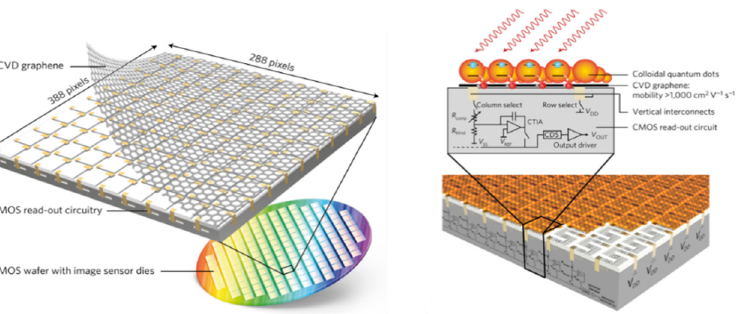
Figure 6. CMOS integration of CVD graphene with image-sensor readout circuit. Embedding of transferred CVD graphene on a 15.1 mm-high and 14.3 mm-wide crystal containing a CMOS image- sensor readout circuit that consists of 388 × 288 pixels ( left ). Side view ( right ) showing a graphene photoconductor lying on a readout circuit. Graphene channels are sensitized to ultraviolet, visible, near-infrared, and short-wave infrared light using QDs: when light is absorbed, an electron–hole pair is generated; due to the built-in electric field, the hole turns into graphene, while the electron remains trapped in the QD [22].